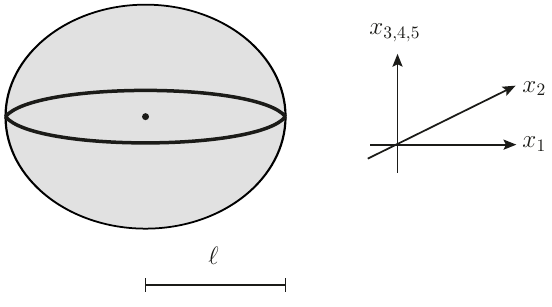
Figure 1 . Wilson loop wrapped around the circle of radius ‘ in the x 1 ; x 2 plane on the